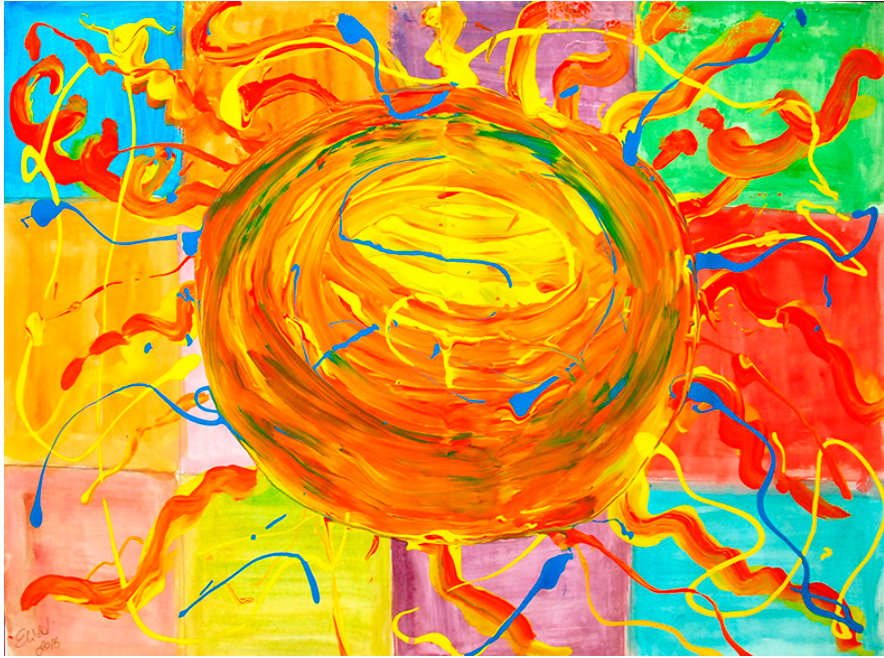
Figure 2. Susanna (aged 47, bipolar disorder), An Engaging Movement, Producing a